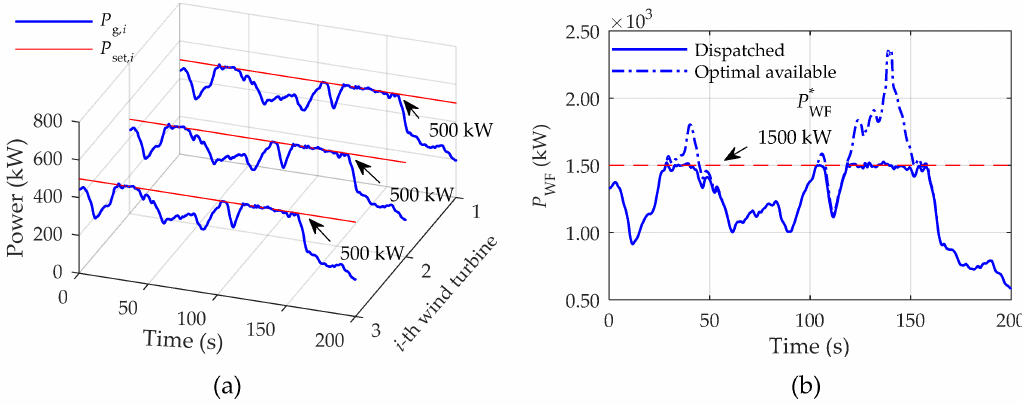
Figure 9. Dispatched active power: ( a ) Wind turbines; ( b ) Wind farm.